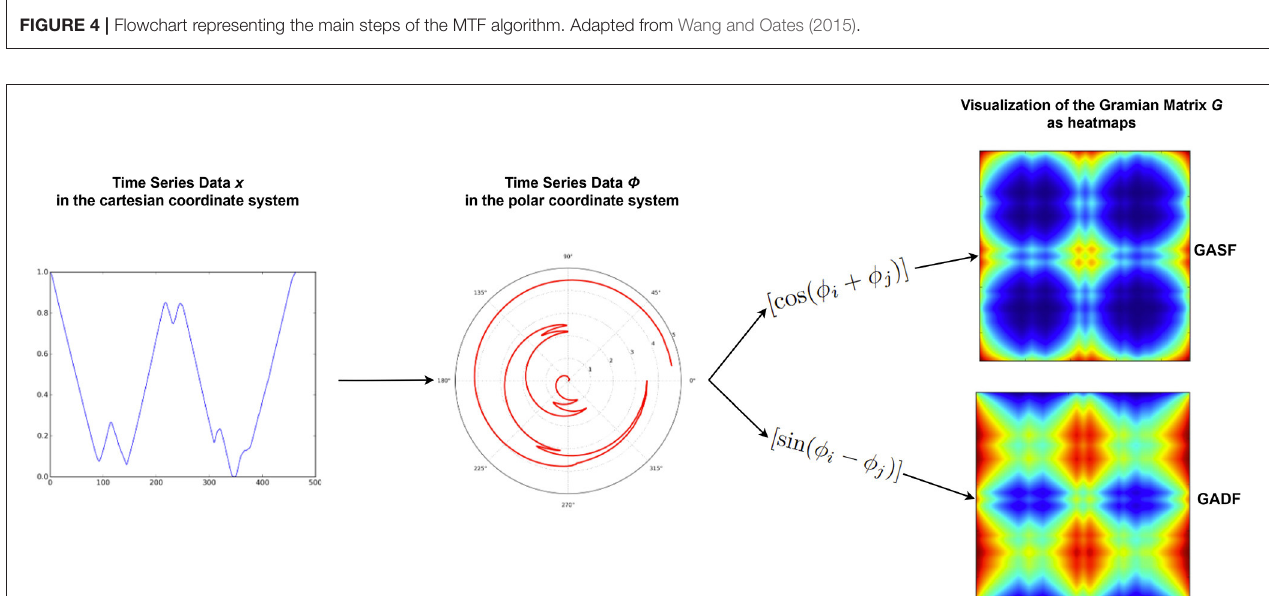
FIGURE 5 | Flowchart representing the main steps of the GAF algorithm. Adapted from Wang and Oates (2015).